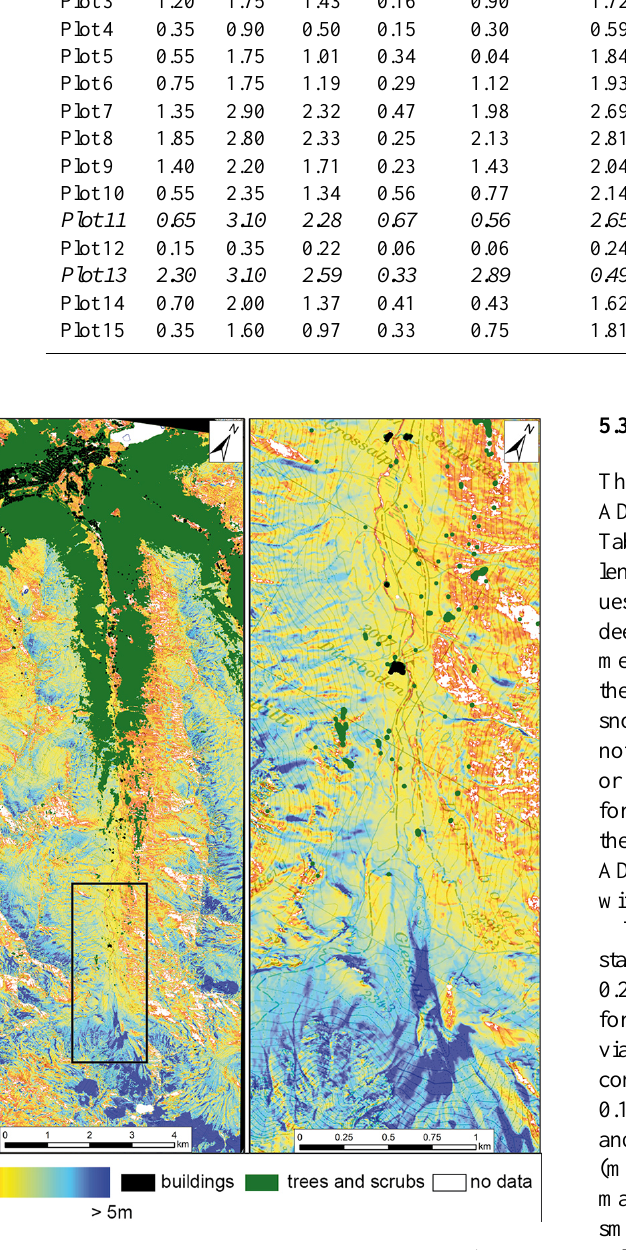
Figure 5. Snow depth map of the entire Dischma area (left, see Fig. 1. for orientation) and a close-up view (right) of the area indi- cated by the black